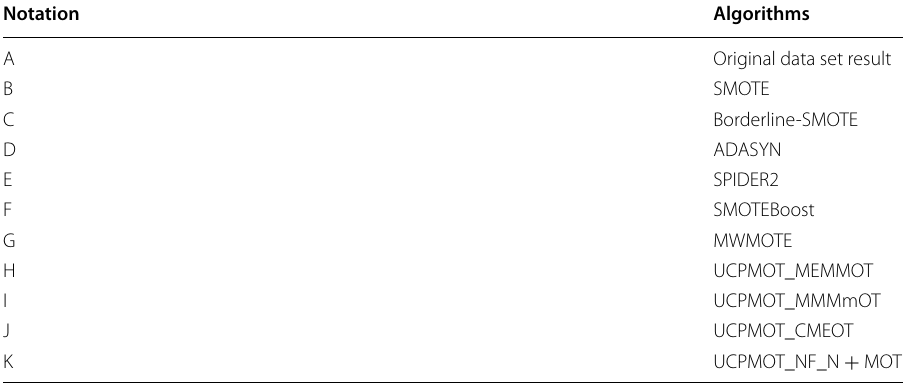
Table 2 Notations